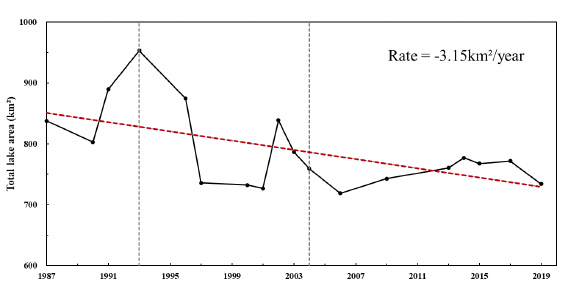
Figure 4 . Changes in the area of lakes in Wuhan